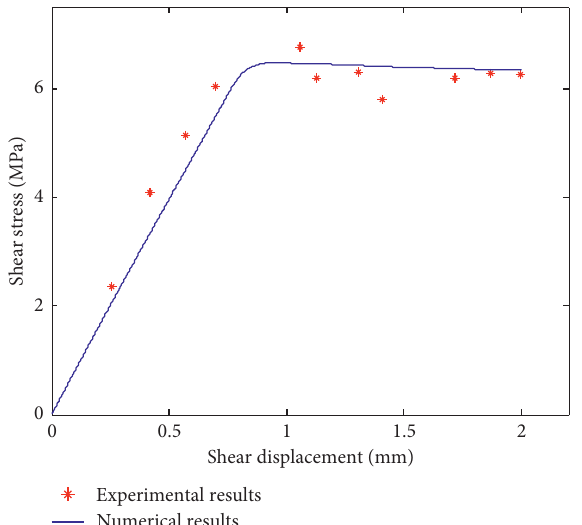
Figure 6: Comparison between numerical simulation result and the experimental test conducted by Moosavi and Bawden